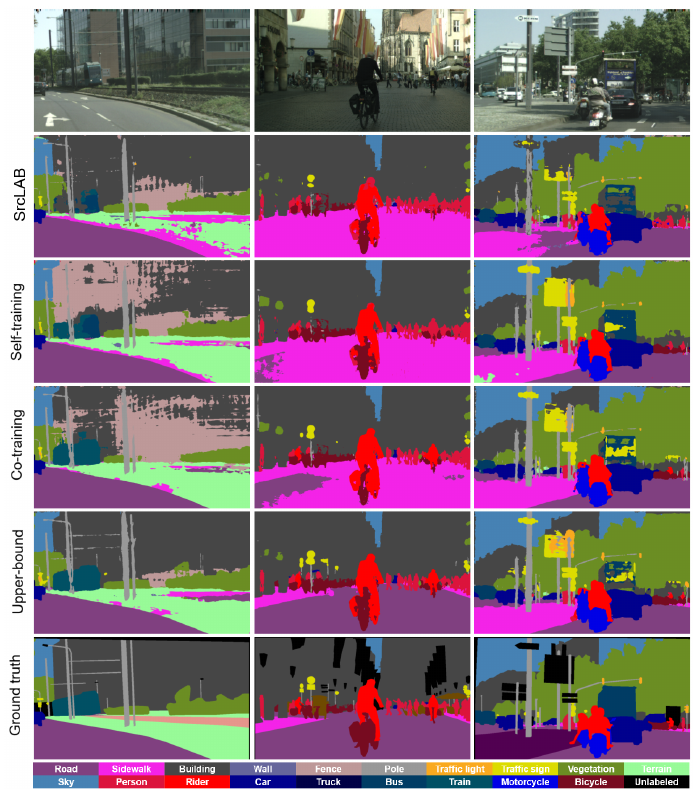
Figure A5. Analogous to Figure A4, focusing on problematic